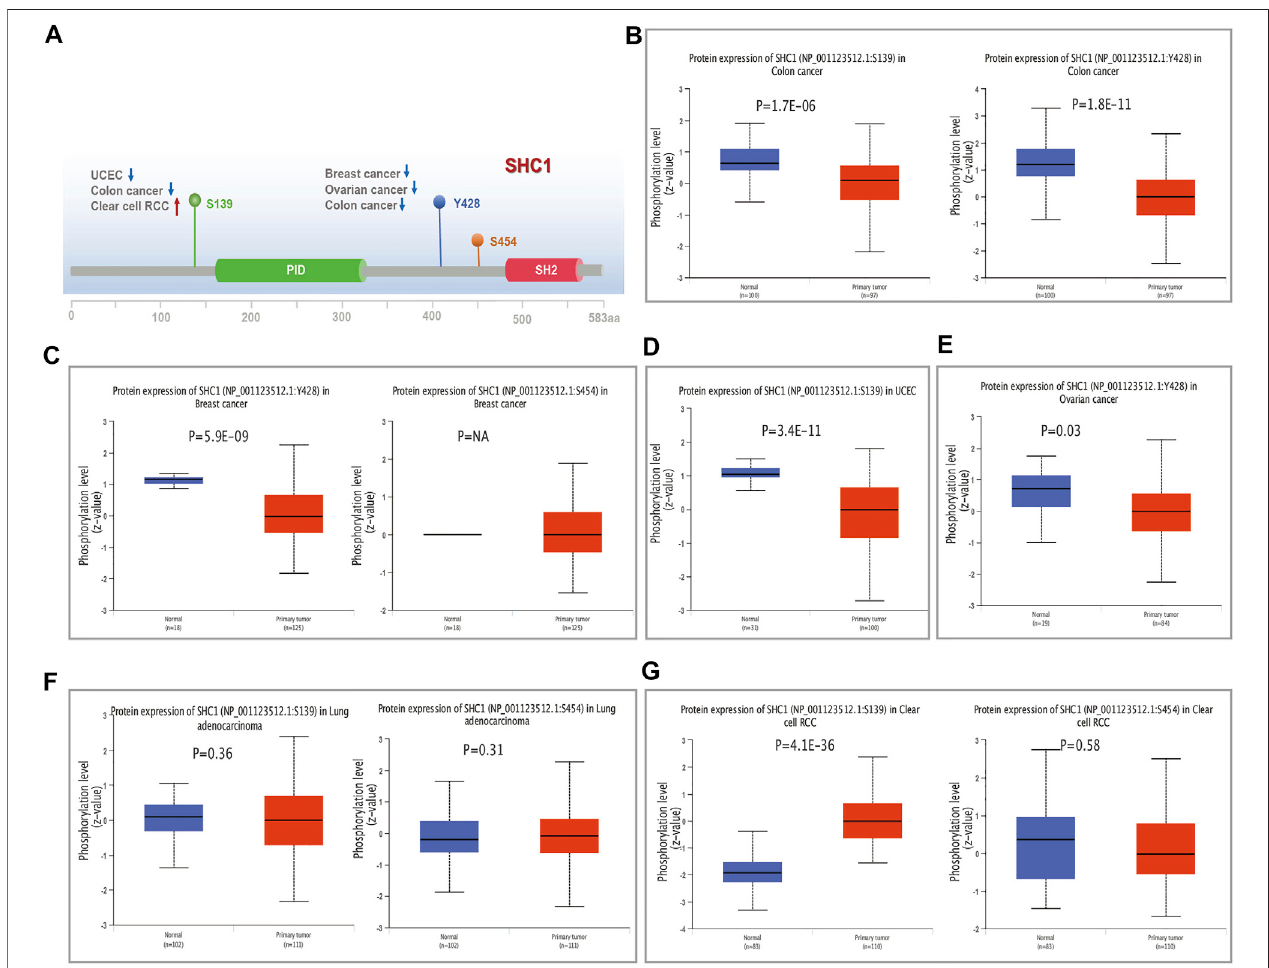
FIGURE 6 | The distribution of SHC1 protein phosphorylation in different tumors. The phosphoprotein levels presented as a schematic diagram of SHC1 protein (A) .ThephosphoproteinlevelsofSHC1innormaltissueanddifferentcancertissues,includingcoloncancer (B) ,breastcancer (C) ,UCEC (D) ,ovariancancer (E) ,LUAD (F) , and clear cell RCC (G)